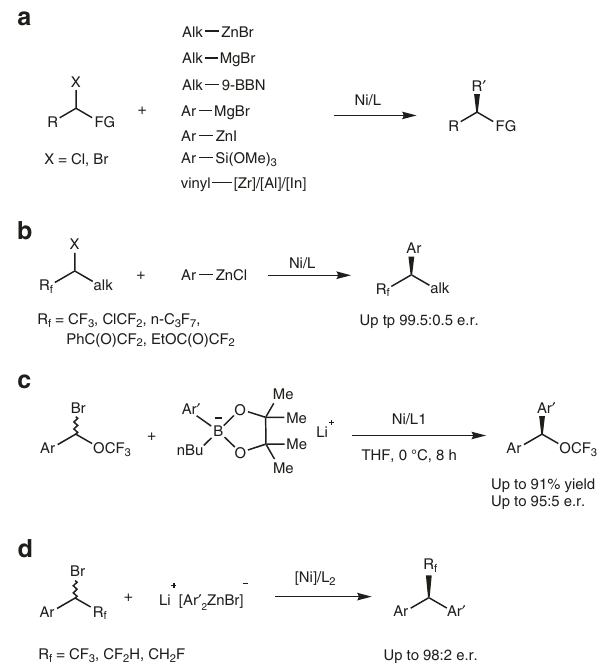
Fig. 1 Ni-catalyzed asymmetric cross-coupling of racemic secondary alkyl halides. a State-of-the-art. b Coupling of fl uoroalkylated secondary alkyl bromides with Aryl zinc chloride. c Coupling with lithium